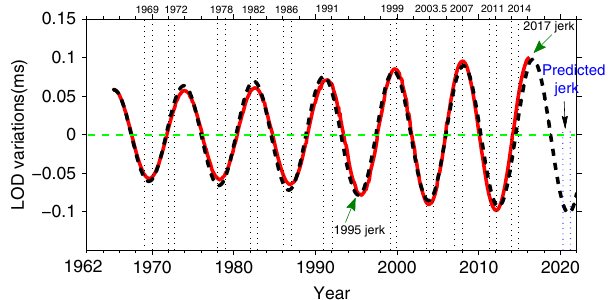
Fig. 4 Correspondence between the 8.6-year signal and geomagnetic jerks. In this fi gure, the red curve expresses the recovered 8.6-year signal in LOD, while the black dashed curve shows the fi tting result (i.e., an exponentially increasing model with the expression of y ( t ) = A 0 exp[ α ( t − t π f ( t − t A ≈ 0.06 ms; the currently 0 )]cos(2 0 )), where the initial amplitude 0 observed exponential rate α ≈ + 0.00131/month; f ≈ 0.00969cpm; the initial time t 0 is set to be at June 1982) of the red curve, which may be used to predict the time when the next new jerk (i.e., the predicted jerk in blue fonts) will probably